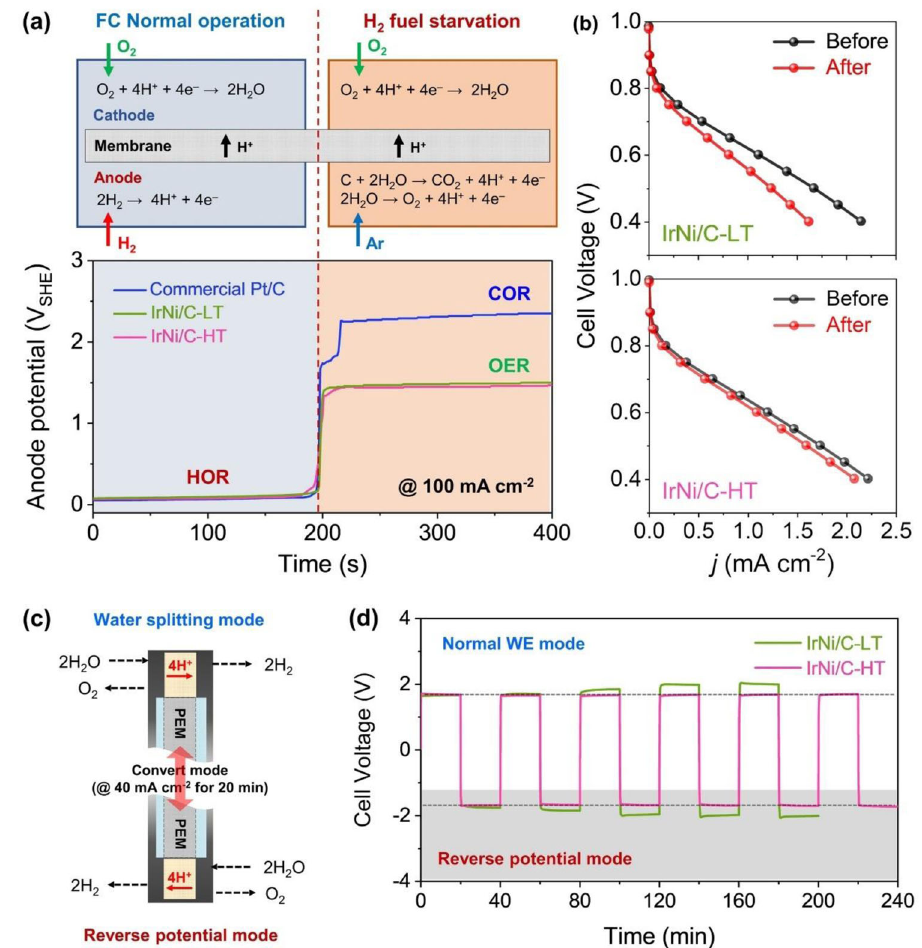
Fig. 6 Reversibility of IrNi/C-HT in water electrolysis and fuel cell systems. a Scheme of the fuel starvation experiment at fuel cell and anode potential behaviors of the commercial TKK Pt/C, IrNi/C-LT and IrNi/C-HT as the anode catalysts under the fuel starvation condition. A single fuel cell test (geometric area: 5 cm 2 ) employing commercial TKK 46% Pt/C as the cathode. b Polarization curves of IrNi/C-HT and -LT before and after fuel starvation experiment. c Scheme of the reverse voltage experiment in water electrolyzer. d Reverse voltage experiment using IrNi/C-LT and IrNi/C-HT as anode and cathode of a single water electrolyzer (geometric area: 10 cm 2 ). Galvanostatic curves obtained with current density of 40 mA cm ‒ 2